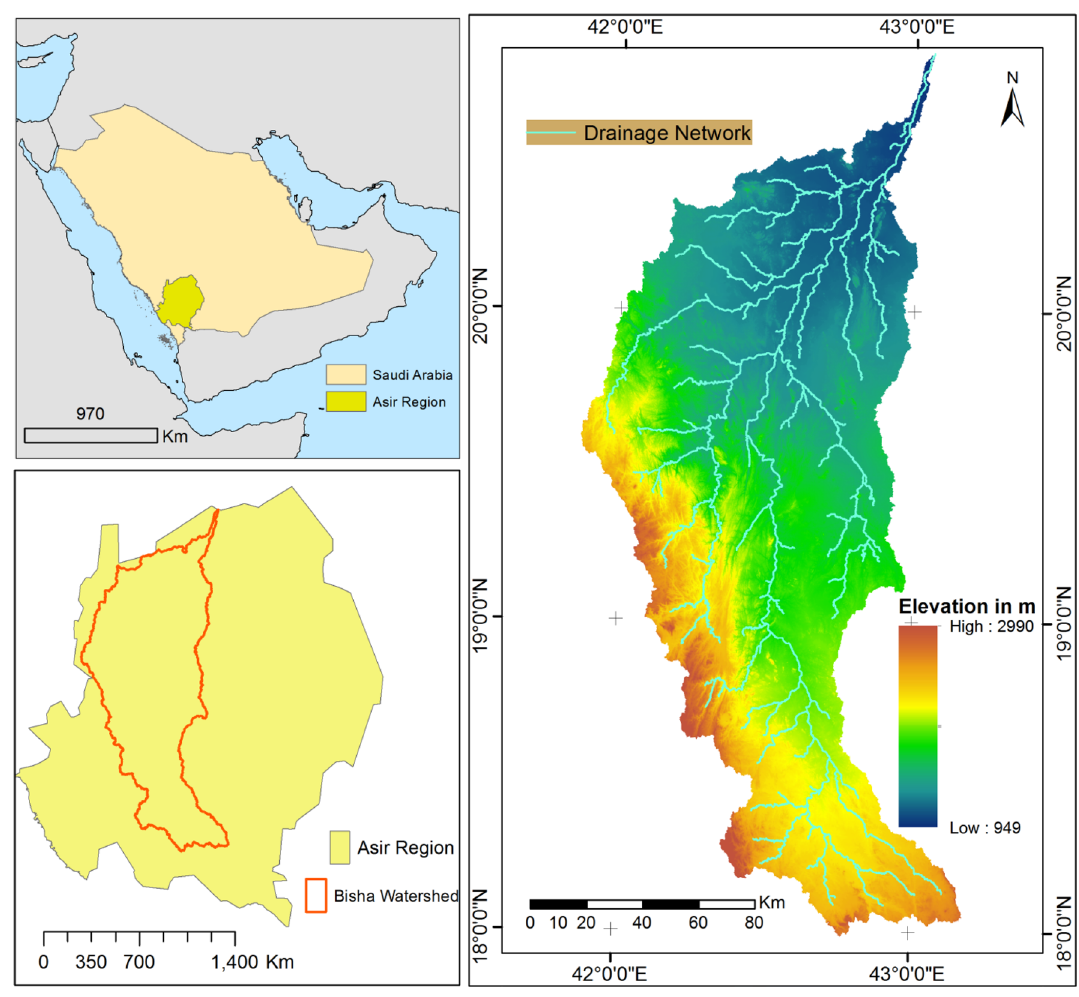
Fig. 1 The study area, Bisha